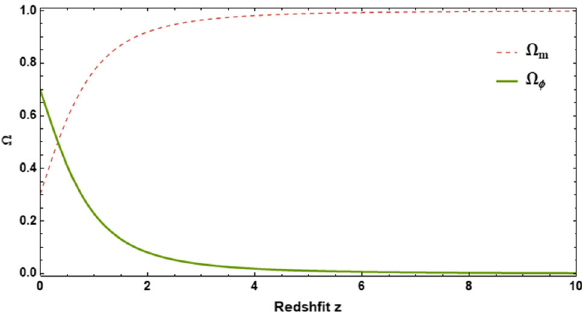
Fig. 1 The evolution of the density parameters of matter (cid:12) m (dashed red) and of quintessence field (cid:12) φ (solid green)